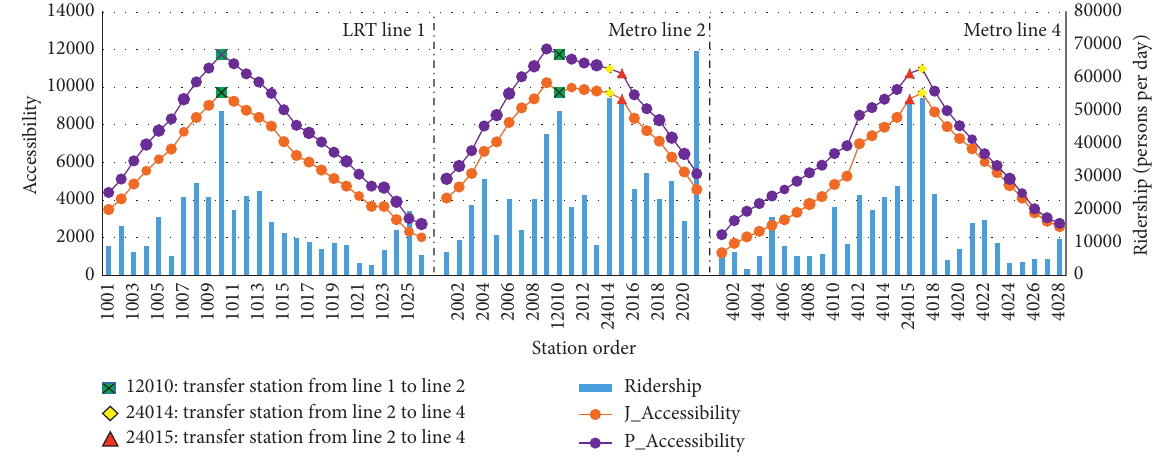
Figure 4: The integrated accessibility and ridership of MRT stations in